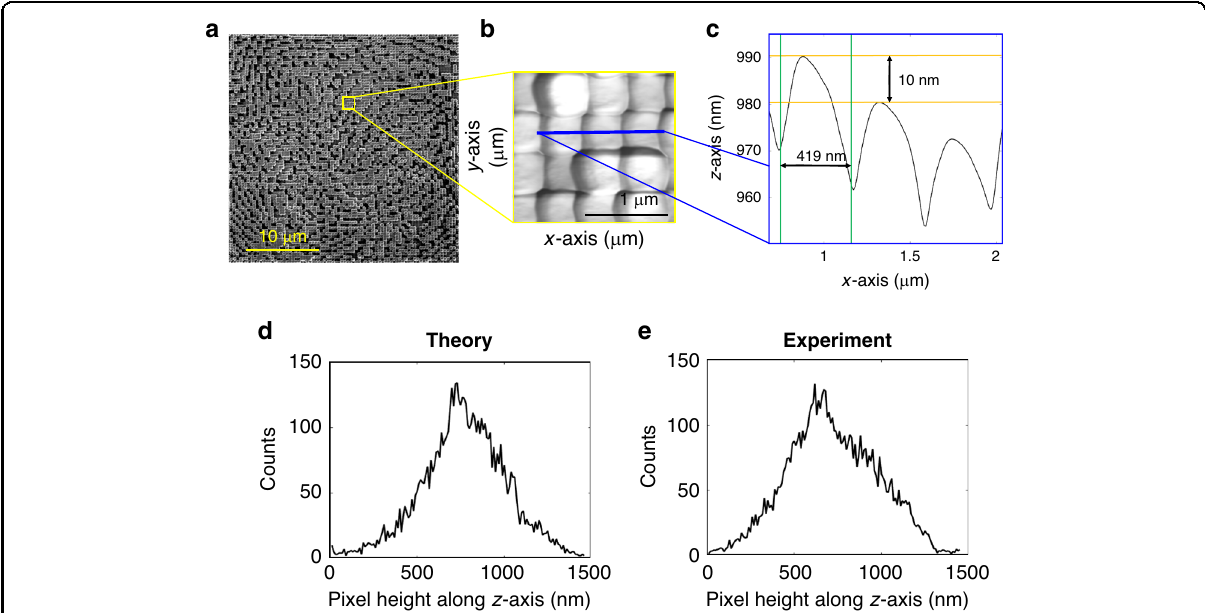
Fig. 3 MLD nanoprinted with GD-TPN. a Scanning electron microscopy (SEM) image of the 3D nanoprinted 9-MLD. The two calculated compact layers (Fig. 2a) are combined in a single compact double layer and printed in a single printing session. AFM topographical image ( b ) of a 9-MLD section. c Height pro fi le along a row of neurons of the 3D-printed 9-MLD. The line pro fi le is taken along the line highlighted in blue in b . The yellow lines in c mark a step in the z direction of 10 nm, while the green lines mark the width of the neuron. Theoretical ( d ) and experimental ( e ) height distributions for the